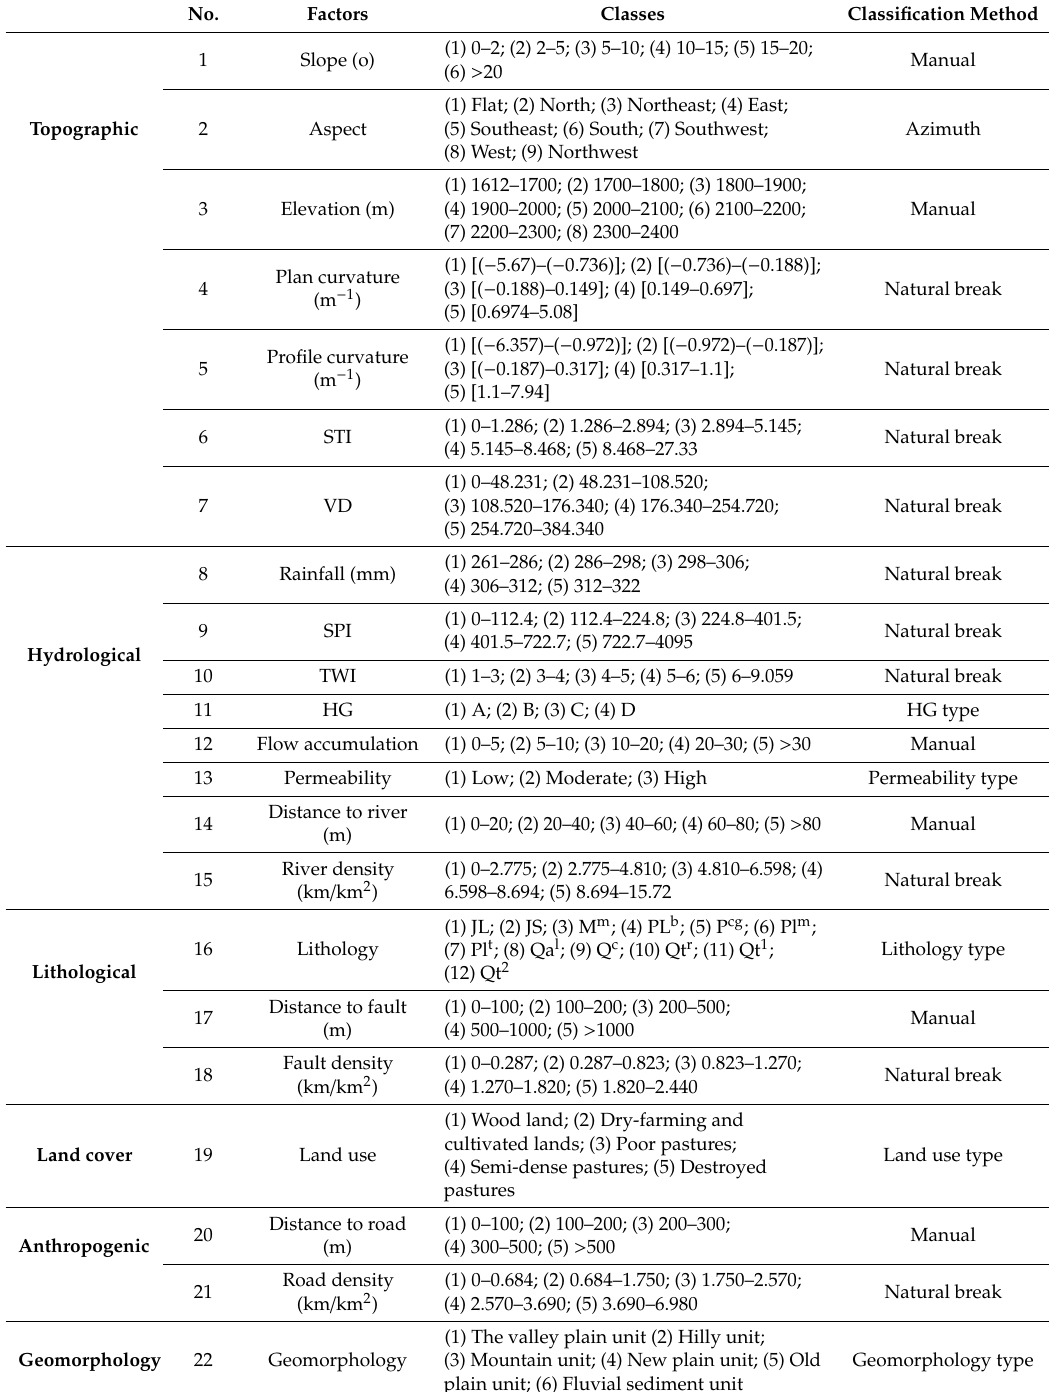
Table 1. Gully conditioning factors and their classes for gully modeling in Klocheh Watershed, Kurdistan Province,